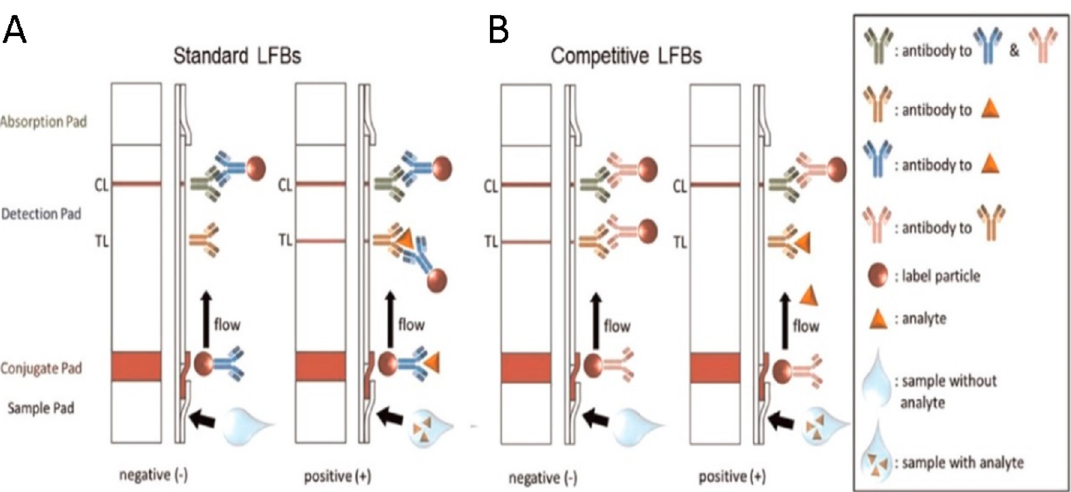
Figure 3. Scheme of a lateral flow test across with ( A ) standard and ( B ) competitive immunoassay. In the standard assay, when the sample is added the liquid start flowing to the conjugate pad where the analytes, if present on the sample, can bind to the label particles. The conjugate can flow by capillarity forces across the detection pad where they are captured only if the conjugate has the analytes attached. Instead, in competitive model the analyte and the label particles compete for being captured on the detection pad obtaining a response inversely proportional to the concentration of analytes. Reproduced with permission from ref. [63].